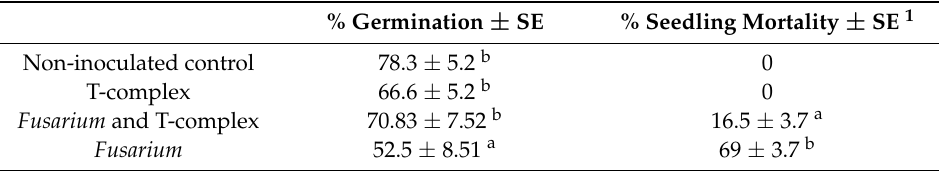
Table 1. Percentage of germination and mortality of P. radiata seeds inoculated with F. circinatum and treated with the T-complex (combination of T. hamatum T3, T. harzianum T6, T. asperellum T20, and T. virens T21; see Materials and Methods). Different letters in the columns indicate significant differences ( p < 0.05), according to Tukey’s post-hoc test. SE—standard error.